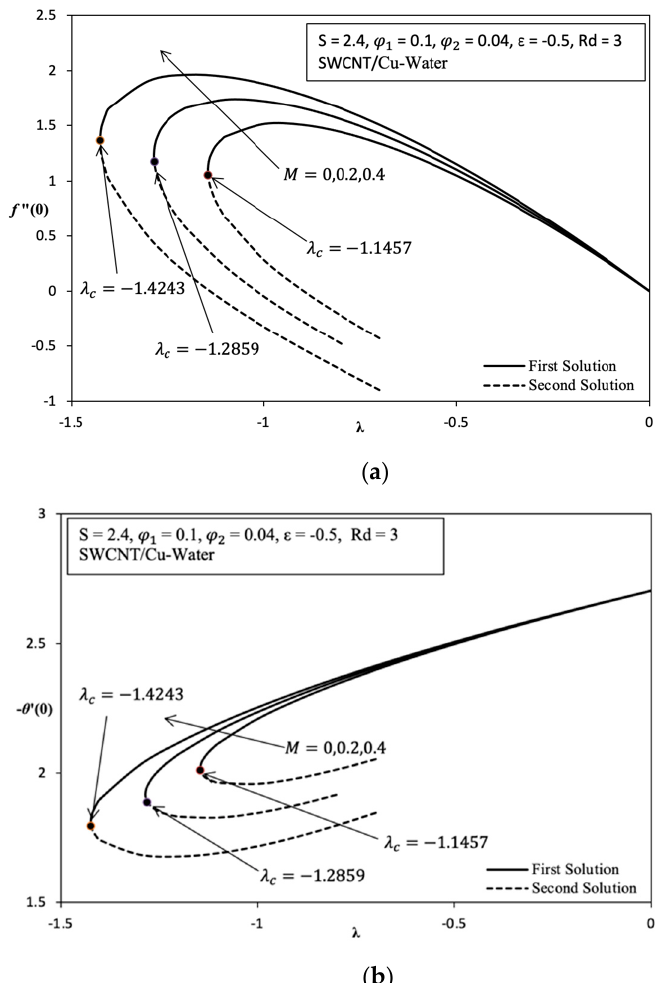
Figure 3. Variation versus λ with different values of M for SWCNT/Cu–water when S = 2.4, ϕ 1 = 0.1, (cid:2030) (cid:2870) = 0.04, ε = − 0.5, Gr = 0, and Rd = 3: ( a ) variation on f ″ (0); ( b ) variation on − θ ′ (0).